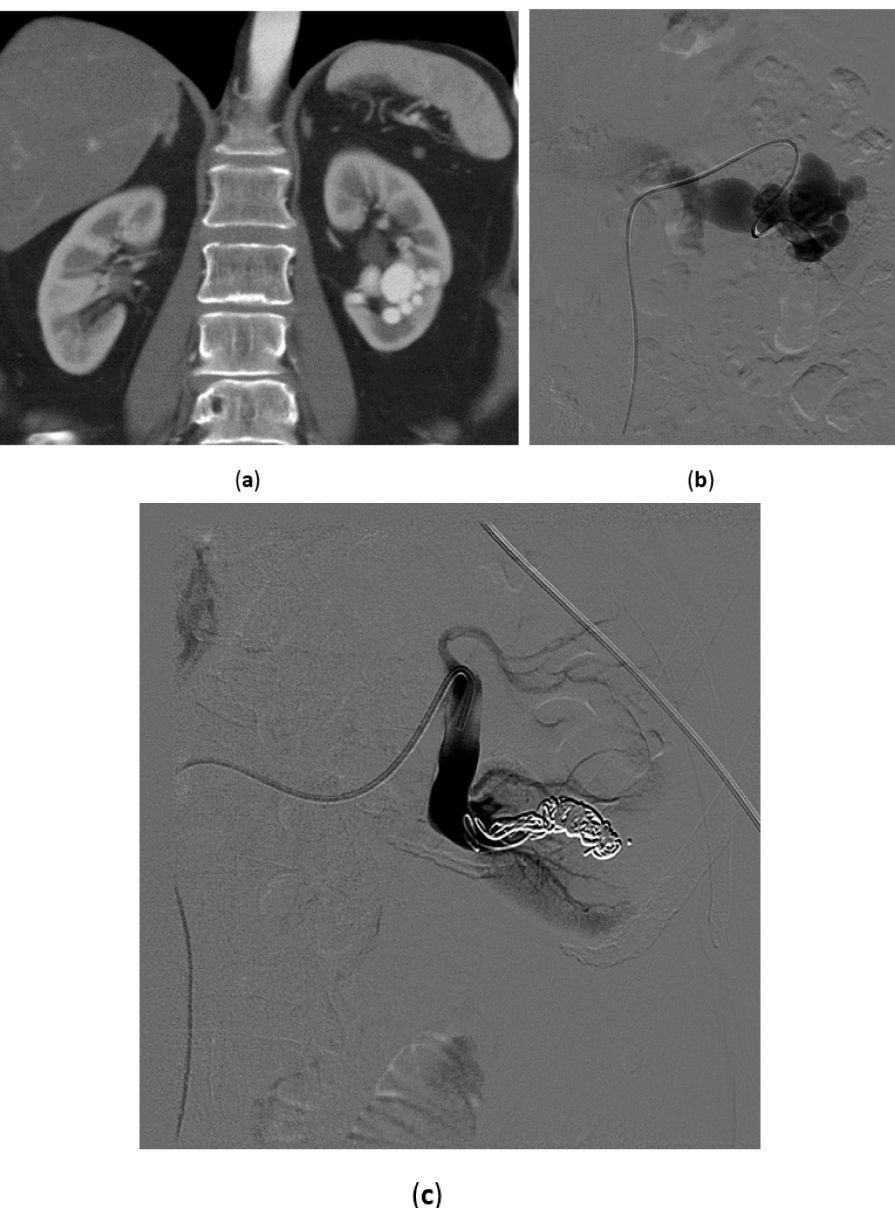
Figure 3. Arteriovenous fistula 59-year-old female, occasional finding on US examination. The patient had no history of previous trauma or renal intervention; thus, the AV fistula was supposed to be congenital. ( a ) Contrast-enhanced CT (arterial phase). The coronal plane well shows dilated vascular structures in the inferior half of the left kidney; ( b ) Selective angiogram of the left kidney confirms the AV fistula with huge dilatation of the renal vein; ( c ) Disappearance of the fistula after embolization with several detachable